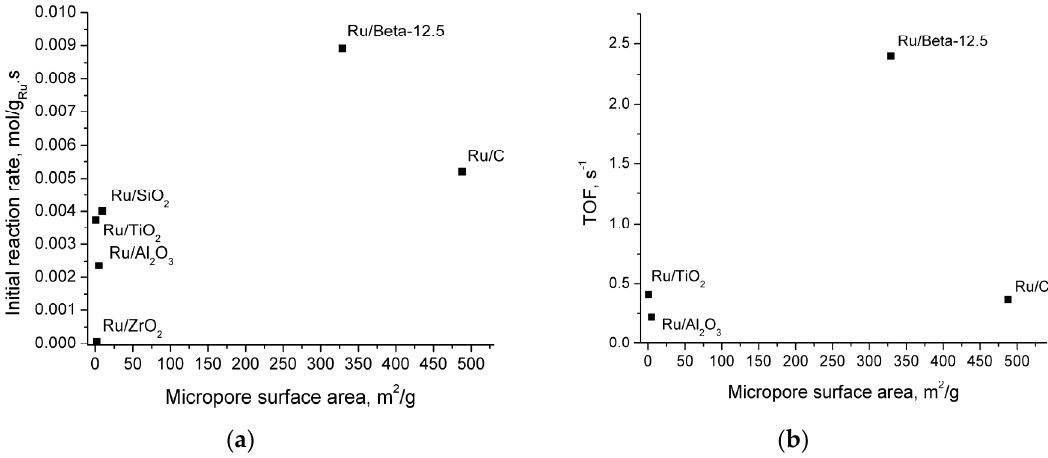
Figure 9. Initial reaction rate and TOF versus the micropore area of the catalysts for LA hydrogenations using supported Ru catalysts. ( a ) Initial reaction rate, ( b ) TOF.